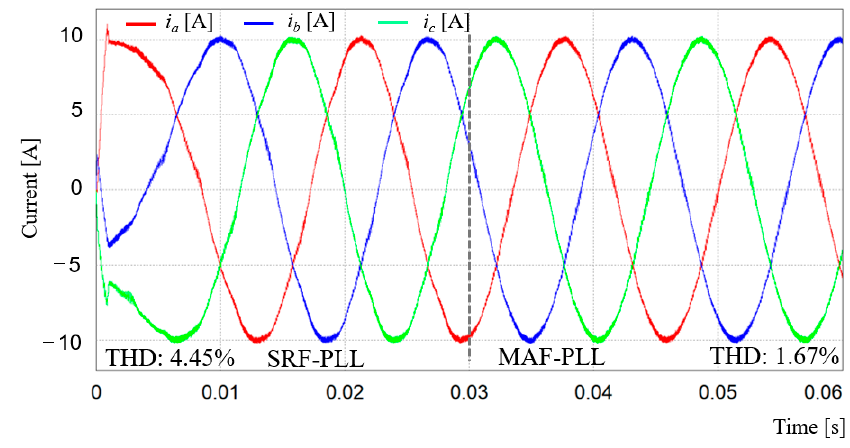
Figure 12. Improvement of the transient response through a modification of the proposed FCS-MPC scheme.